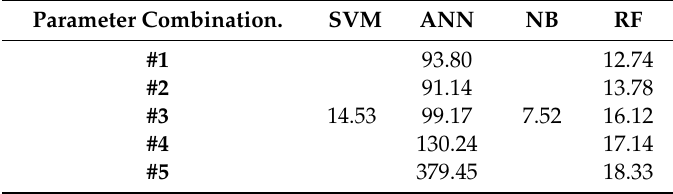
Table 11. Execution time for each model for Varaždin (in seconds). Parameter Combination.